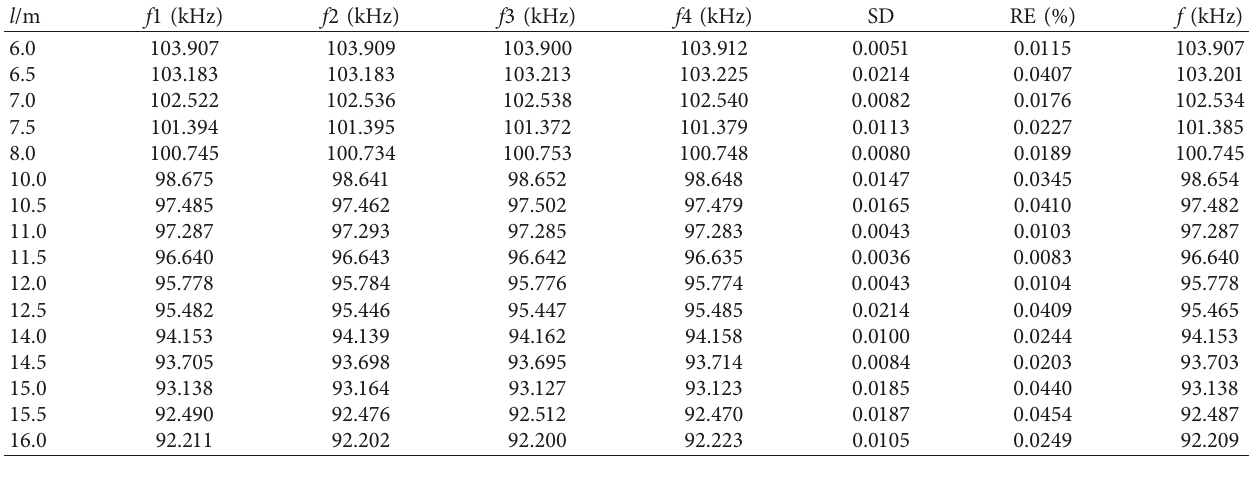
Table 4: V 15.2mm experimental data of strand length.